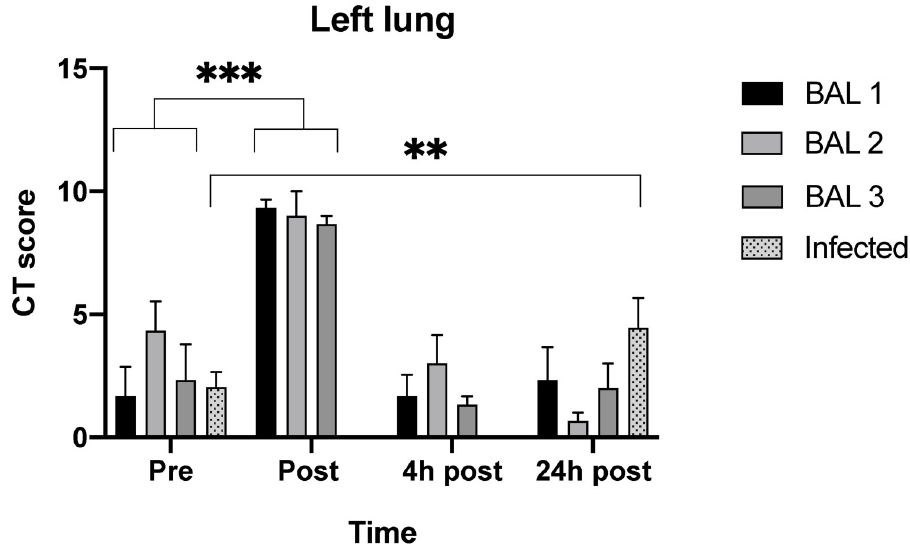
Fig 2. Average CT scores of the left lung of both non-infected (n = 3) and infected (n = 11) macaques. For the non- infected group, the average CT scores of the four timepoints are represented for BAL 1, 2 and 3. As for the SARS-CoV- 2 infected group the average CT scores of the two timepoints are represented. Post-BAL 1, 2 and 3 the CT scores of the non-infected group were significantly higher compared to pre-BAL 1, 2 and 3. The infected group showed a significant increase in post-BAL CT score compared to pre-BAL. Values are mean ± SEM, Wilcoxon signed-rank test was performed; �� p < 0.01, ��� p <